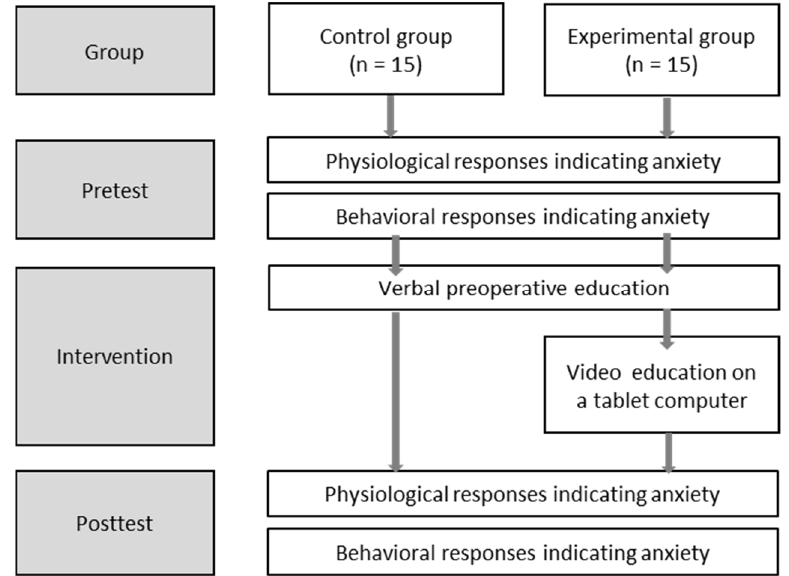
Figure 1. Process flow diagram.